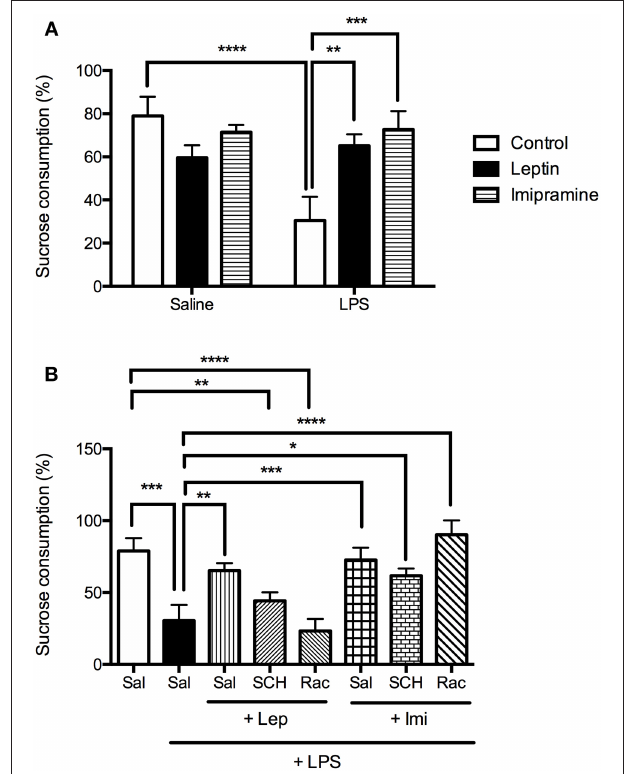
FIGURE 4 | Sucrose preference measured as % of sucrose consumption of animals submitted to protocol 1 (A) and protocol 2 (B) . Bars represent mean ± standard error of the mean (S.E.M.) of 6 animals/group. The results in part A were analyzed by two-way ANOVA, while in part B by one-way ANOVA, in both cases with Tukey’s as post-hoc test. * P < 0.05, ** P < 0.01, *** P < 0.001, **** P < 0.0001 as indicated by the connectors. Sal, saline; SCH, SCH23390; Rac, raclopride; Lep, leptin, Imi, imipramine; LPS,